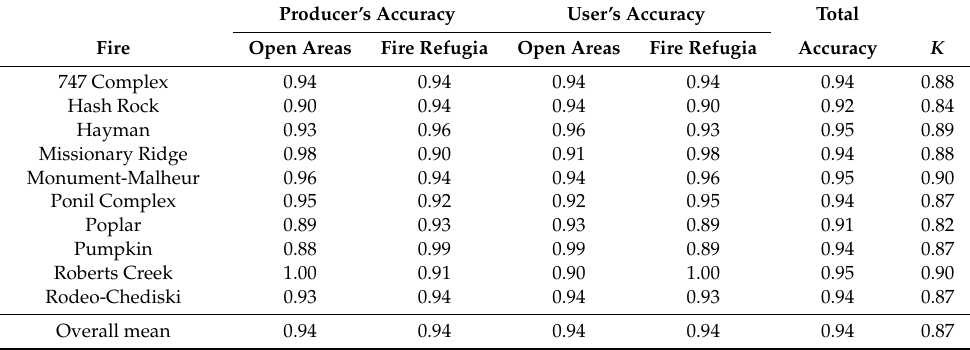
Table 2. Imagery-based accuracy assessments from confusions matrices computed for each fire.